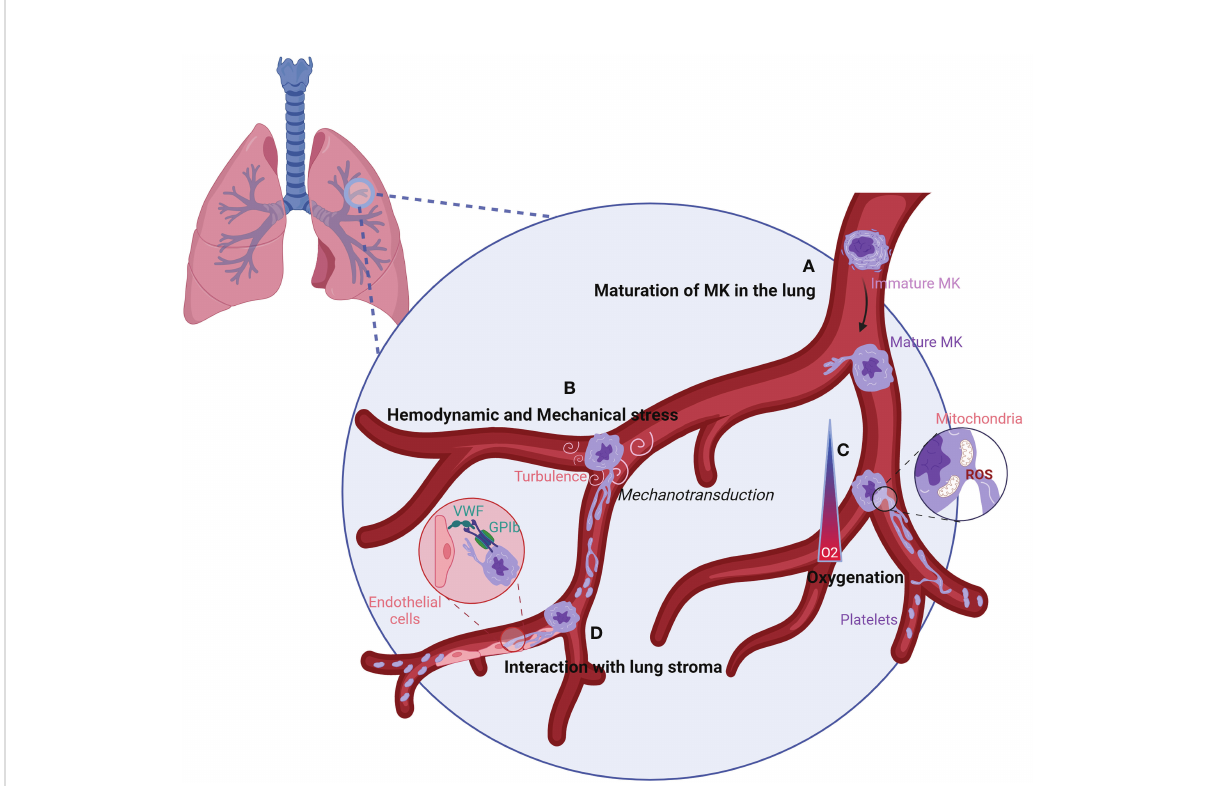
FIGURE 4 Characteristics of the lung vasculature that could favor ef fi cient platelet production. (A) When MKs reach the lung vasculature, they can sense the lung microenvironment leading to their maturation into adaptated MKs. (B) The lung vasculature could harbor the perfect size and turbulence for MK elongation into platelets. Following sensing of mechanical stress and high turbulence by MKs, signals could be transmitted by mechanotransduction leading to proplatelet and platelet production. (C) The oxygenation of the lung vasculature is elevated, which could increase the mitochondrial fi ssion and generation of mtROS at the MK membrane. ROS production induces the remodeling of the cytoskeleton, ending up in platelet production. (D) The interaction between vWF, enriched on lung endothelial cells, and GPIb on MKs could allow MKs to sense shear stress, resulting in the elongation of MKs and platelet formation. GP1b/CD42, Glycoprotein 1b/Cluster of Differenciation 42; MK, megakaryocyte; O2, Oxygen; ROS, Reactive Oxygen Species; vWF, von Willebrand